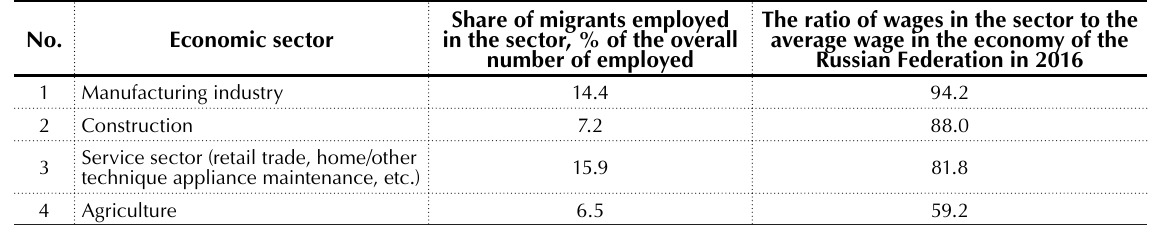
Table 1. Relative employment rates of migrants and sectoral wages in the Russian Federation in 2016 (%) Source: Compiled based on the Federal State Statistics Service (Abridged Statistical Book) (2017)